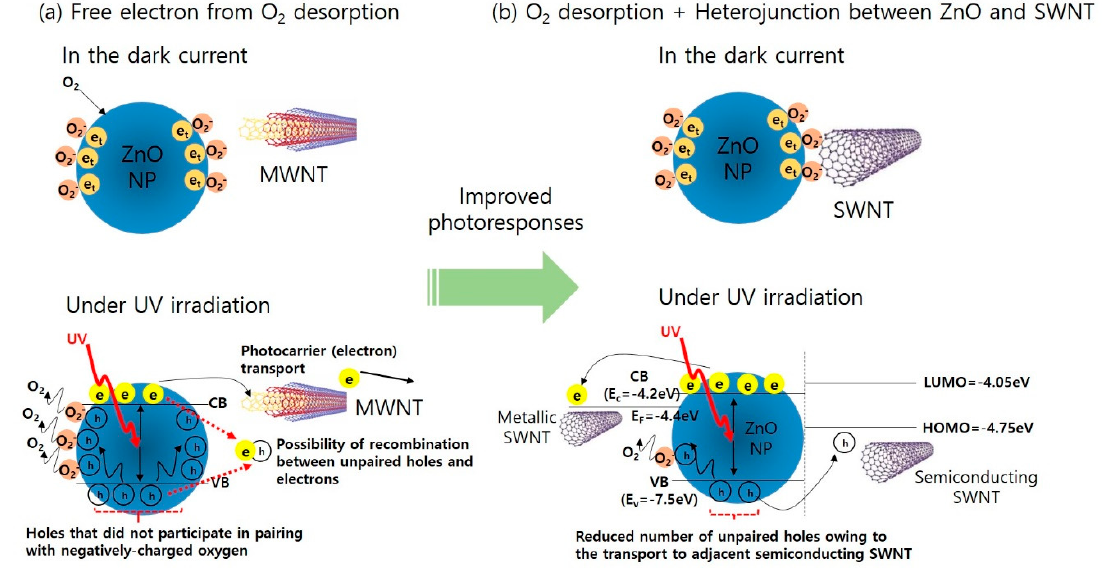
Figure 6. Illustration of the photocurrent mechanism for ( a ) ZnO@MWNT, free-electron generation from oxygen desorption under UV light, and ( b ) ZnO@SWNT, combination of oxygen desorption and hole depletion (electron enrichment) at the p-n heterojunction under UV light.